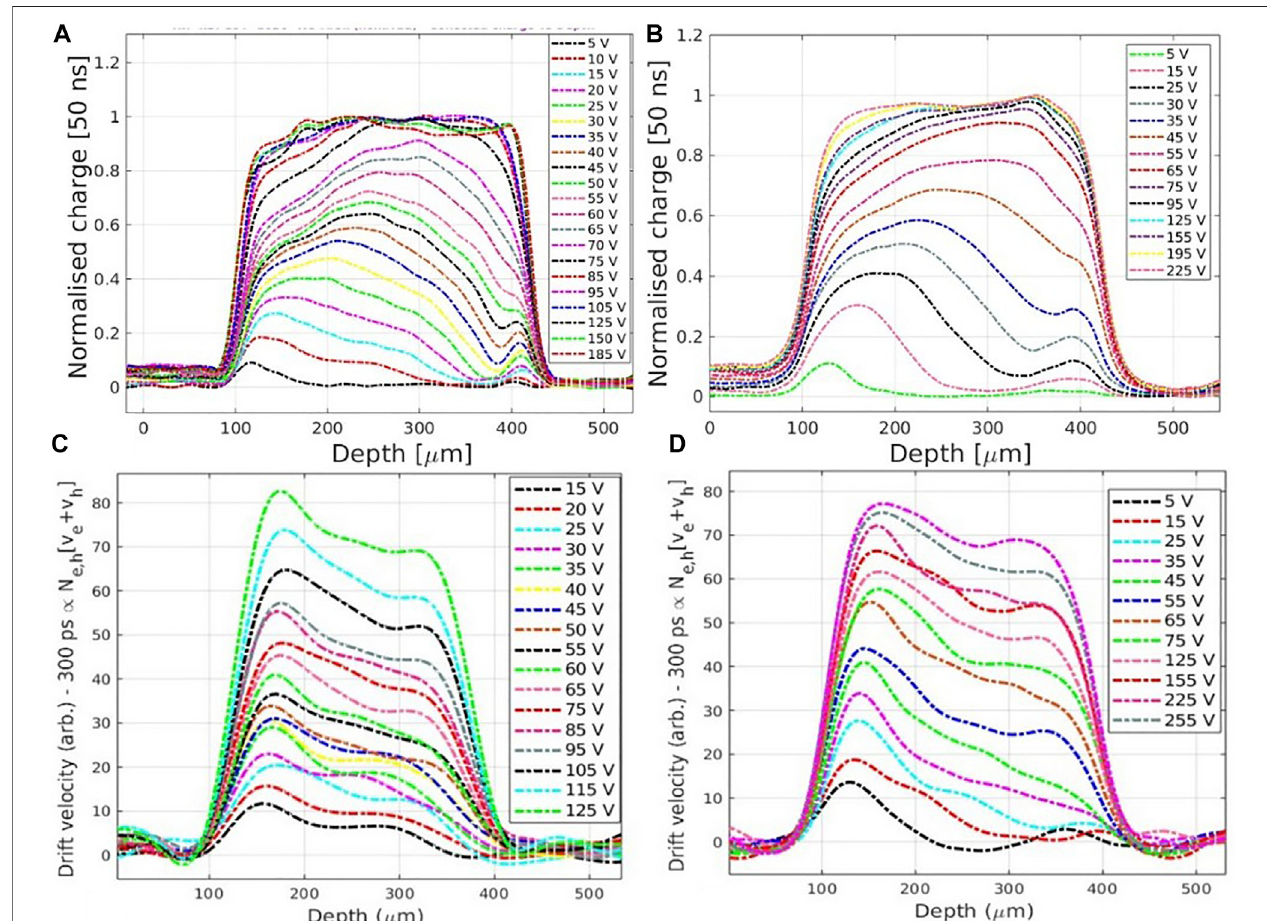
FIGURE13| Normalizedcollectedchargeversusdepthpro fi lesatvaryingbiasvoltagesfornon-irradiatedAC-coupledpixelsensorswith (A) Al 2 O 3 and (B) Al 2 O 3 + HfO 2 as theinsulatinglayer, measured at room temperature. Driftvelocitypro fi les at varying biasvoltages fornon-irradiated sensors with (C) Al 2 O 3 and (D) Al 2 O 3 +HfO 2 as the insulating layer, measured at room